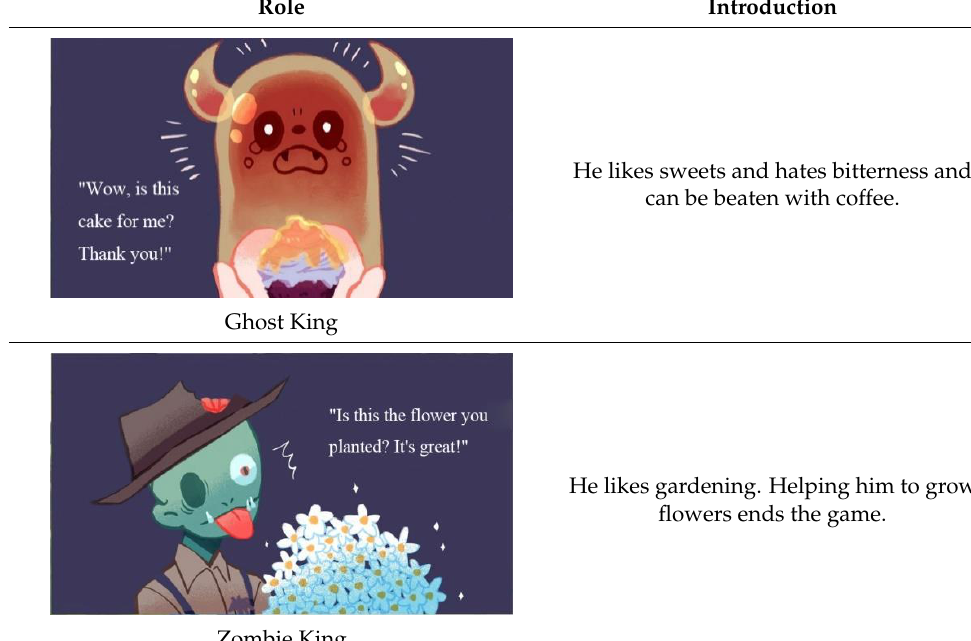
Figure 3. Operation of investigating and hiding. Table 8. Partial props. Prop Gameplay